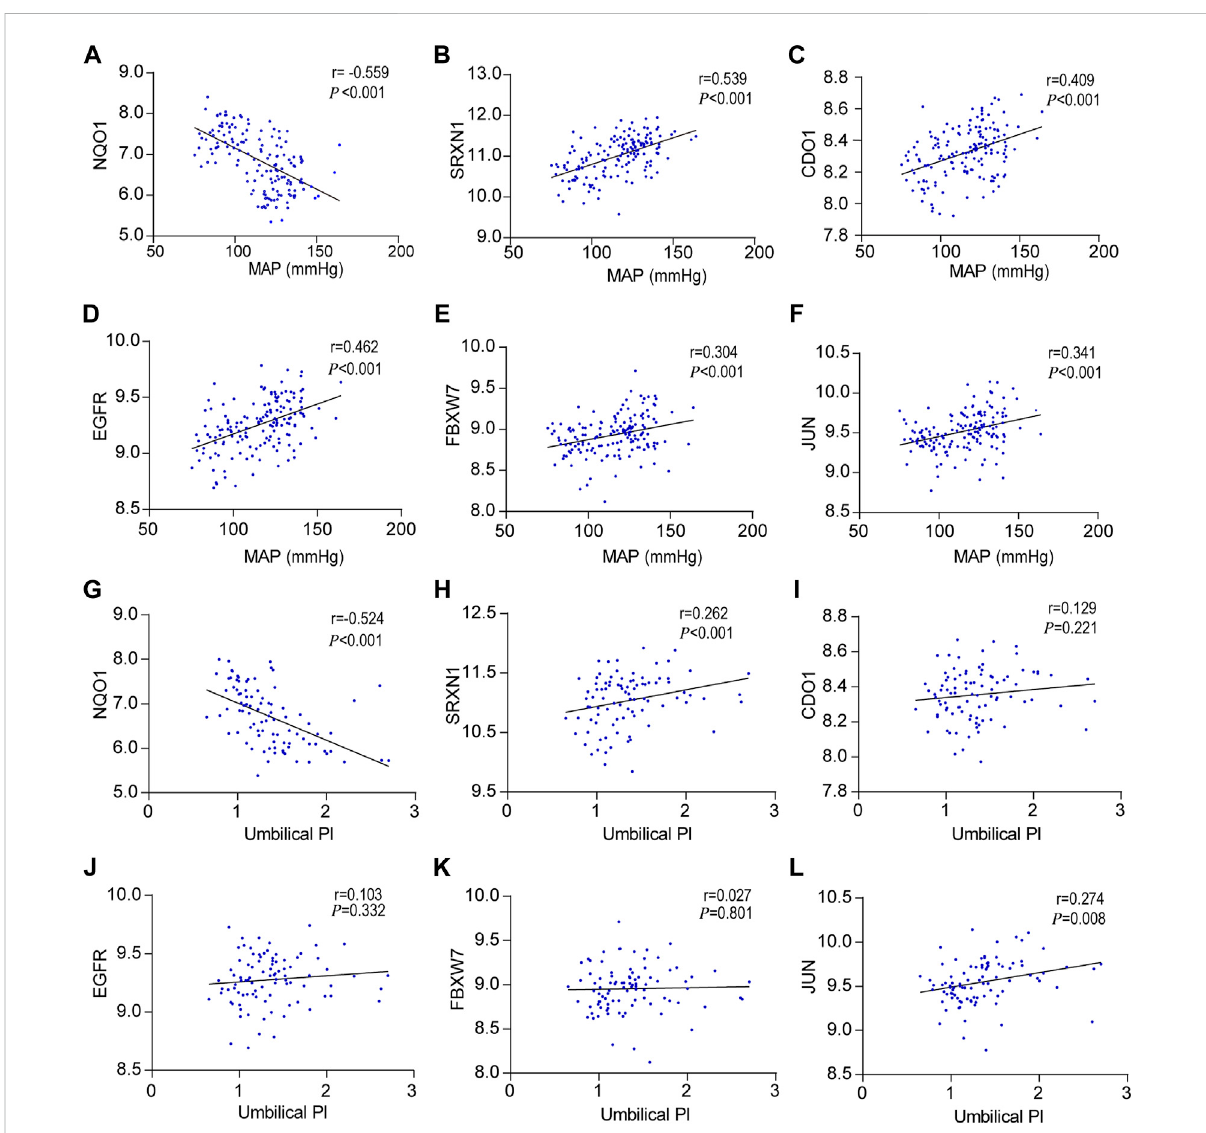
FIGURE 5 Correlationbetweenhubgenesexpressionlevelsandclinicalfeatures, (A – F) PearsoncorrelationplotsbetweenMAPandNQO1,SRXN1,CDO1, EGFR, FBXW7, and JUN. (G – L) Pearson correlation plots between umbilical PI and NQO1, SRXN1, CDO1, EGFR, FBXW7, and